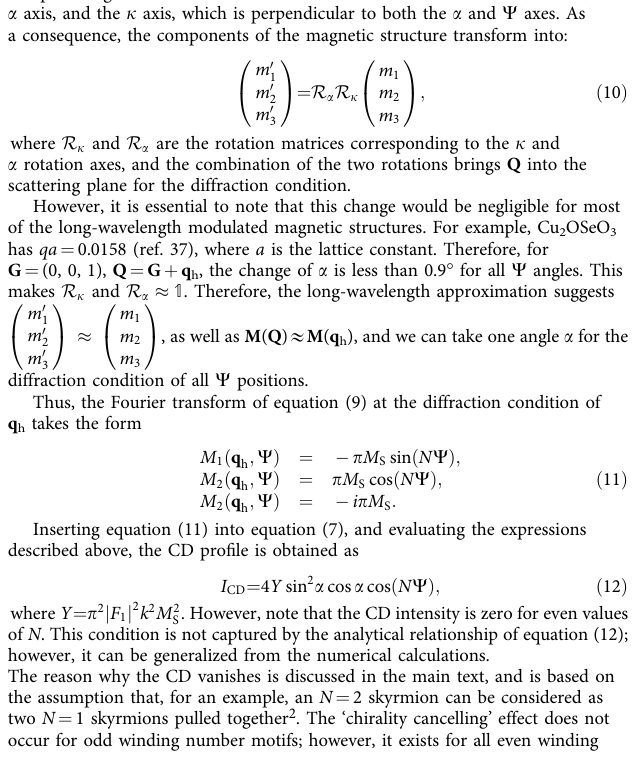
Figure 4 | Robustness of the measurement principle. ( a ) Spin configuration of a Ne´el-type skyrmion with N ¼ 1, ( b ) calculated CD profile, and, ( c ) calculated PAM. ( d ) Spin configuration of an anti-skyrmion with N ¼ (cid:5) 1. Note that the anti-skyrmion, as well as other topological entities with negative topological numbers, are not energetically stable states. Nevertheless, our experimental principle can be applied, as shown in e , f in which the CD profile and PAM periodicity suggest the correct absolute value of the winding number. Moreover, negative winding numbers give rise to a fundamentally different PAM shape of the humps. This provides an additional way to distinguish positive from negative values of N To meet the diffraction condition for Q ¼ G þ q h at C , one has to bring Q into the scattering plane. In a common four-circle diffractometer, this is achieved by